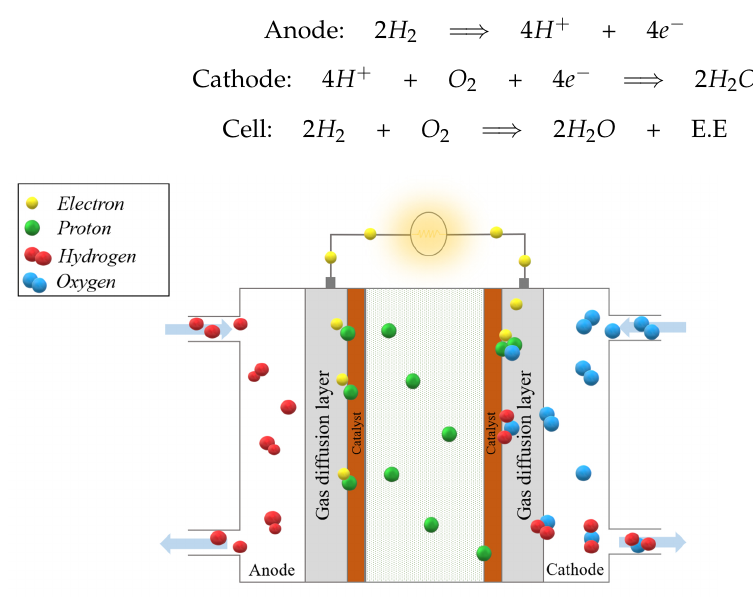
Figure 1. A cross-section of a